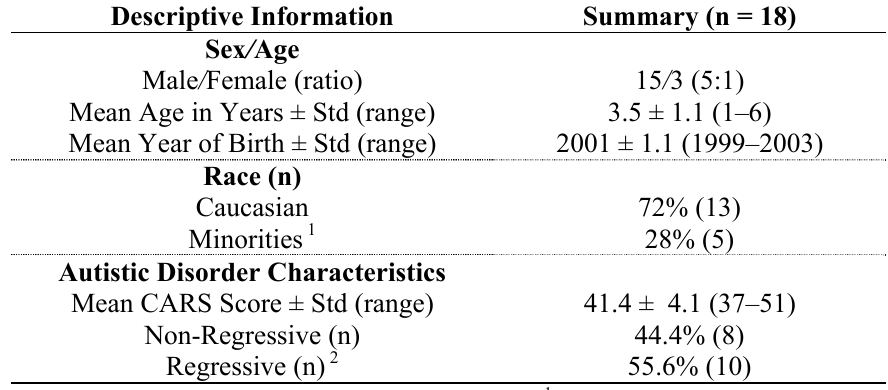
Table 1. A demographic summary of the participants diagnosed with an ASD